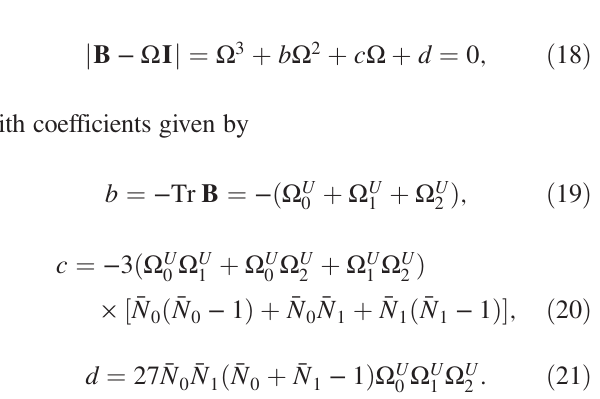
filling pattern case with M ¼ 3 read Ω U 0 ¼ ð − 7923 . 2 ;